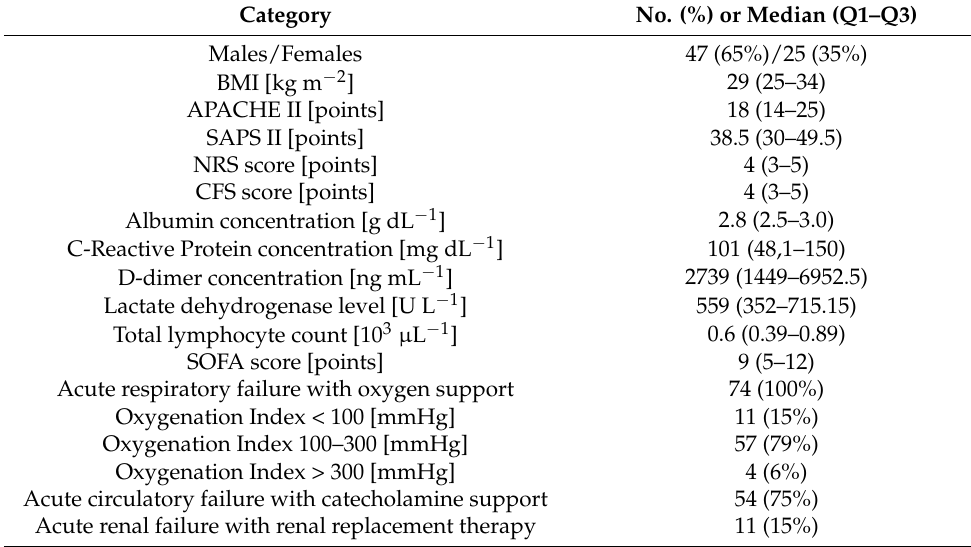
Table 1. Characteristics of the study population (at ICU